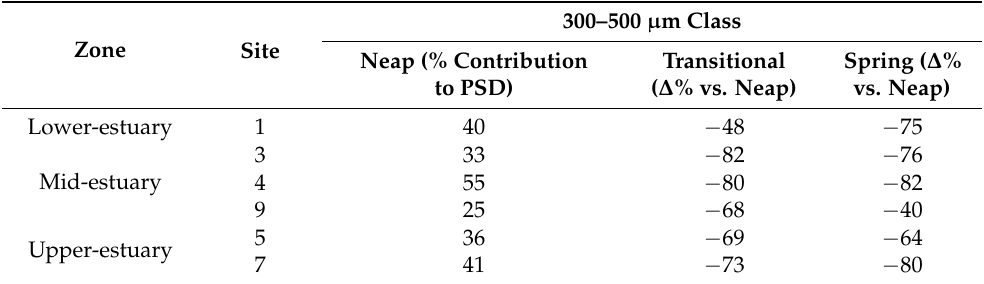
Table 4. Surface-water mean percentage contribution of the 300–500 µ m class to the PSD within the lower- (Site 1), mid- (Sites 3, 4, and 9), and upper-estuary (Sites 5 and 7) sites based on the neap sample conditions and percentage change ( ∆ %) of the size class contribution based on transitional and spring sample conditions in comparison to neap condition contributions. 300–500 µ m Class Zone Site Neap (% Contribution Transitional Spring ( ∆ % to PSD) ( ∆ % vs. Neap) vs. Neap) Lower-estuary 1 40 − 48 − 75 3 33 − 82 − 76 Mid-estuary 4 55 − 80 − 40 5 36 − 69 − 64 Upper-estuary 41 − 73 −